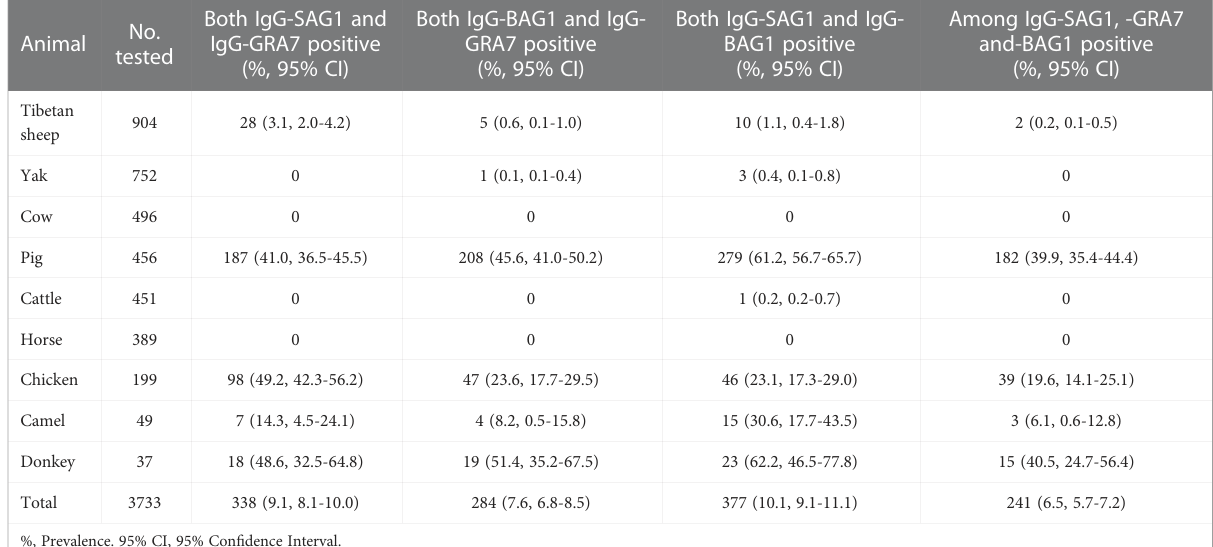
TABLE 3 Speci fi c- T. gondii IgG-positive animals based on among SAG1, GRA7 and BAG1 proteins.